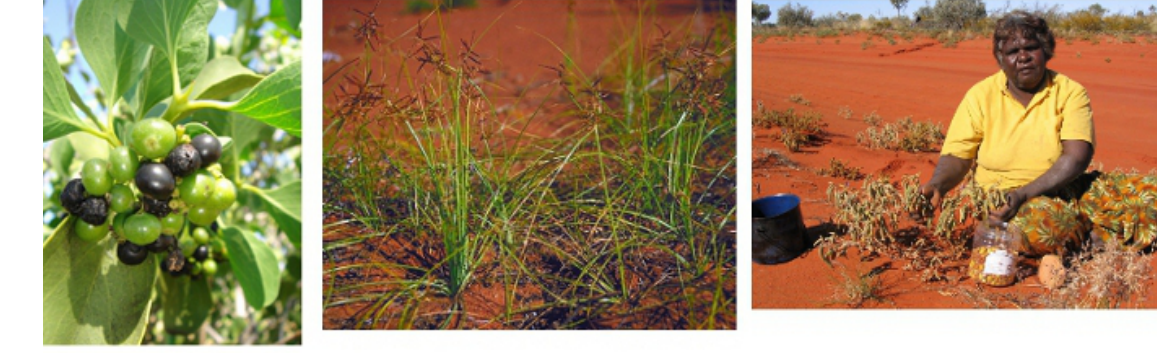
Fig. 8. Examples of Arrernte merne (food plants) noted in this paper. (Left) ripe and unripe Ahakeye merne (Bush currant fruit) (Photo by J. Moloney); (middle) Yalke (Bush onion) before plant has dried, then tubers are suitable for harvest; (right) ripe Akatyerre merne (Desert raisin) fruit picked before dry stage by Eileen Bonney. (Photos by F. Walsh.) Table 1 names and describes these